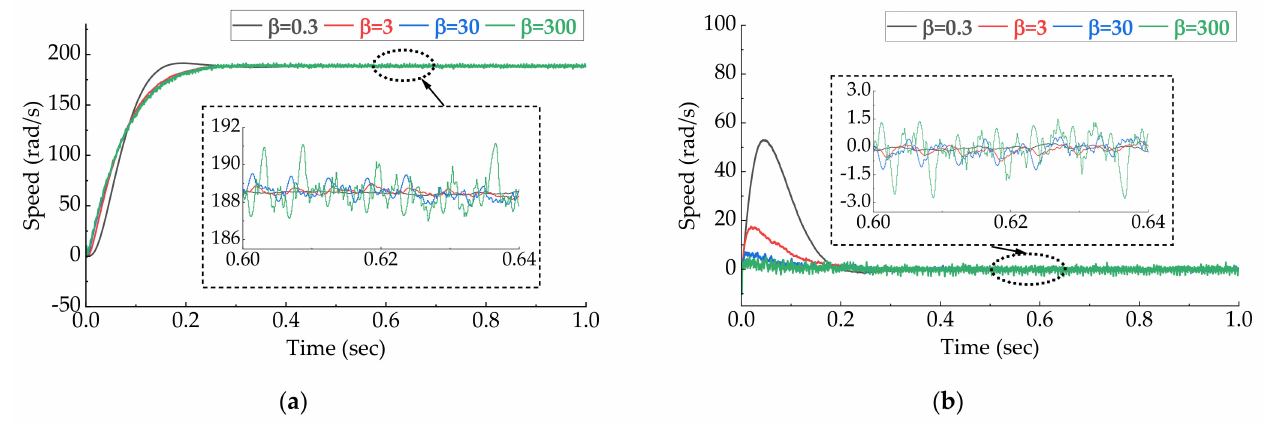
Figure 7. ( a ) Speed estimation based on the method in [22]. ( b ) The difference between the actual speed and the speed estimated is based on the method in [22].